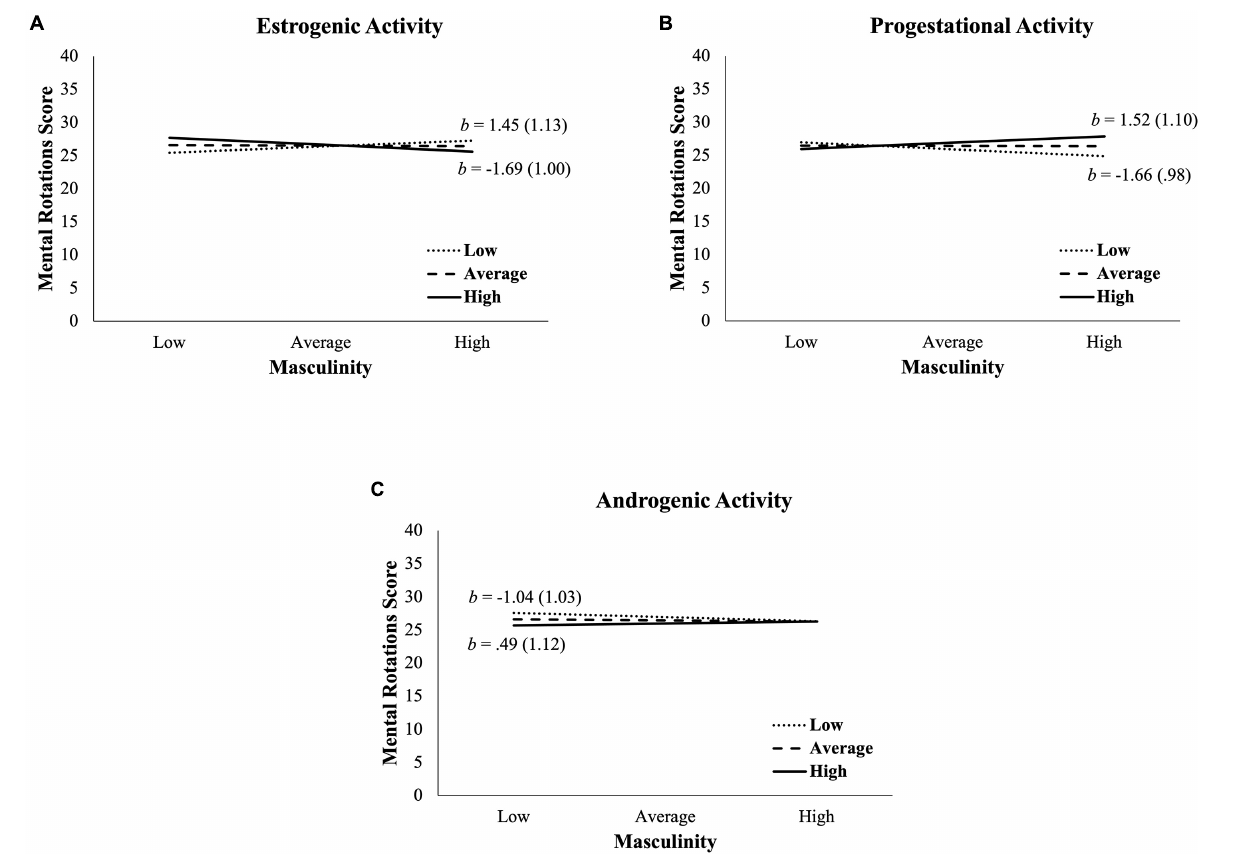
FIGURE 2 | Relation between masculinity and spatial skills (operationalized by three-dimensional mental rotations skill) plotted by oral contraceptive hormone activity (operationalized by a novel 4-point coding scheme). (A) The masculinity and spatial skills relation was significantly moderated by OC estrogenic activity. (B) The masculinity and spatial skills relation was significantly moderated by OC progestational activity. (C) The masculinity and spatial skills relation was not moderated by OC androgenic activity. Dotted, dashed, and solid black lines reflect low, average, and high hormone activity, respectively. Low vs. high hormone activity and masculinity reflect the conditional effect for the model estimated for scores ± one standard deviation from the mean, respectively. Unstandardized coefficients ( b ) reflect the masculinity-mental rotations relation for the low and high hormone activity levels with standard errors in parentheses. See Table 2 for results of statistical